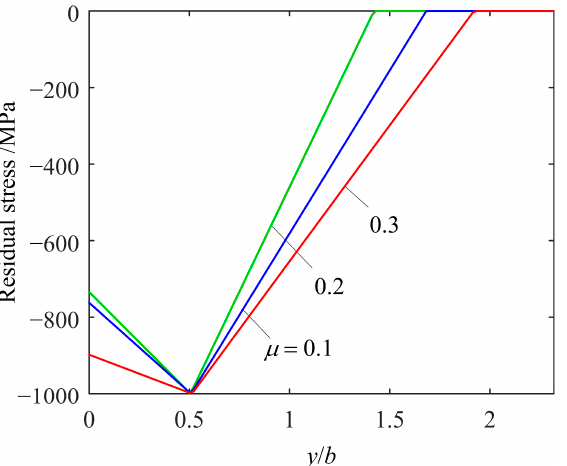
Figure 10. The optimum RS distribution along the depth for P / P rated = 1 and μ = 0.1, 0.2, and 0.3.